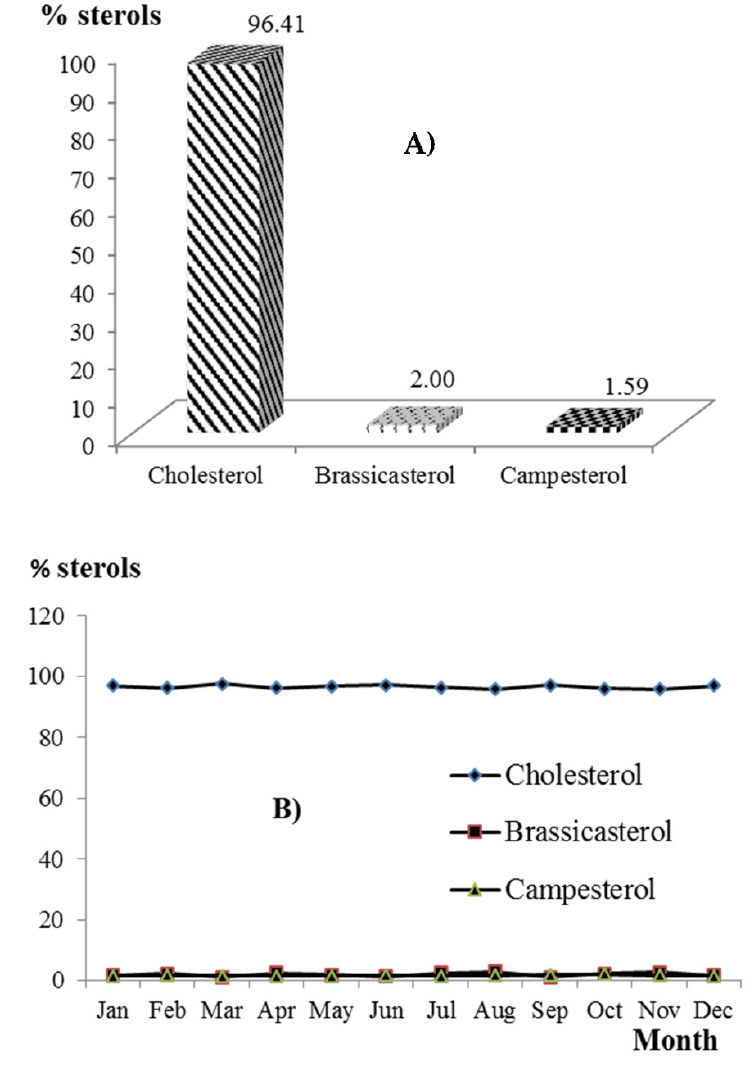
Figure 4. ( A ) Mean values (% of total sterols) of cholesterol, brassicasterol, and campesterol in milk produced in Tecpatán, Chiapas; ( B ) distribution of sterols over